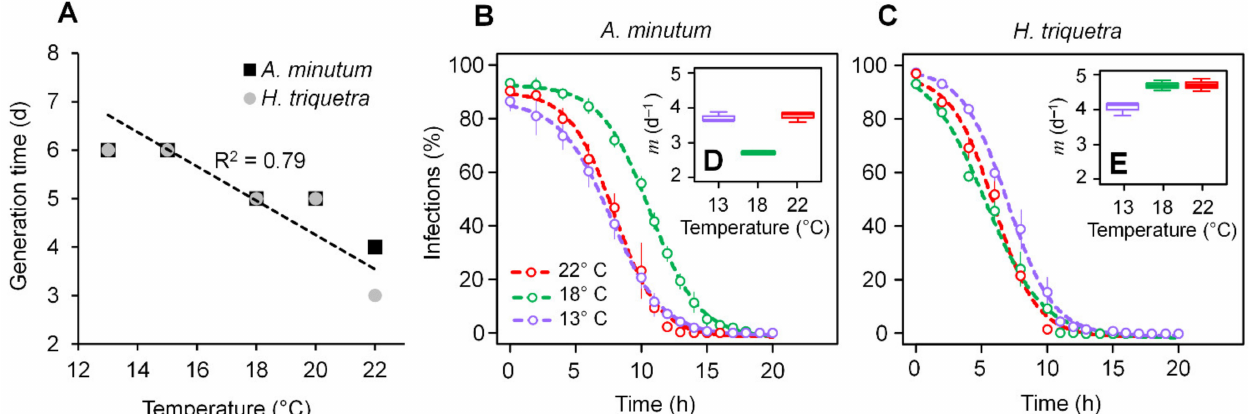
Figure 2. Effect of temperature on Parvilucifera rostrata RCC2823 generation time from infections in the dinoflagellates Alexandrium minutum and Heterocapsa triquetra ( A ); decrease in zoospore infectivity with age in P. rostrata RCC2823 infecting A. minutum ( B ) and H. triquetra ( C ). The effect of temperature on the mortality of P. rostrata RCC2823 zoospores produced from infections in A. minutum ( D ) and H. triquetra ( E ) are shown as insets in ( B ) and ( C ),